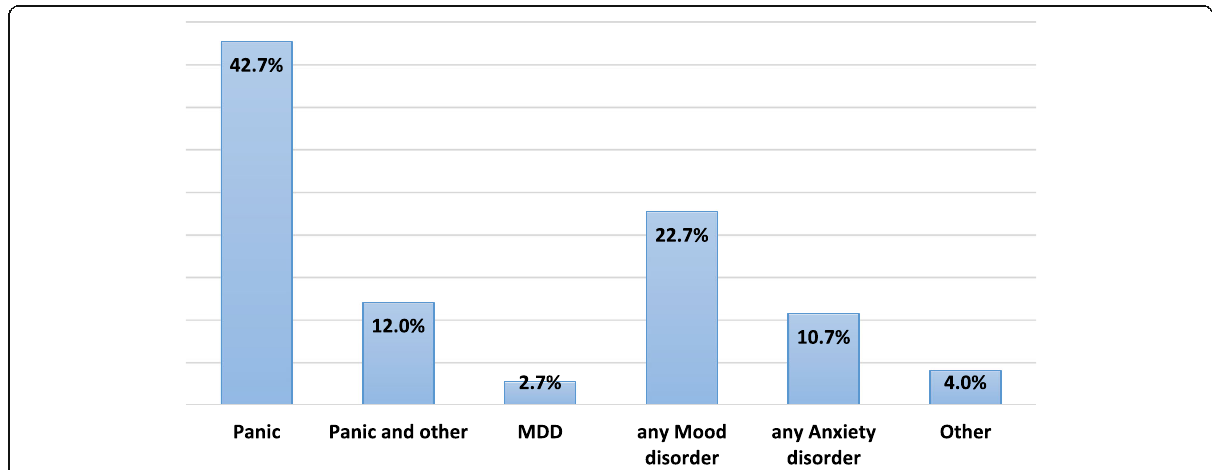
Fig. 2 Prevalence rate of psychiatric disorders among agoraphobia